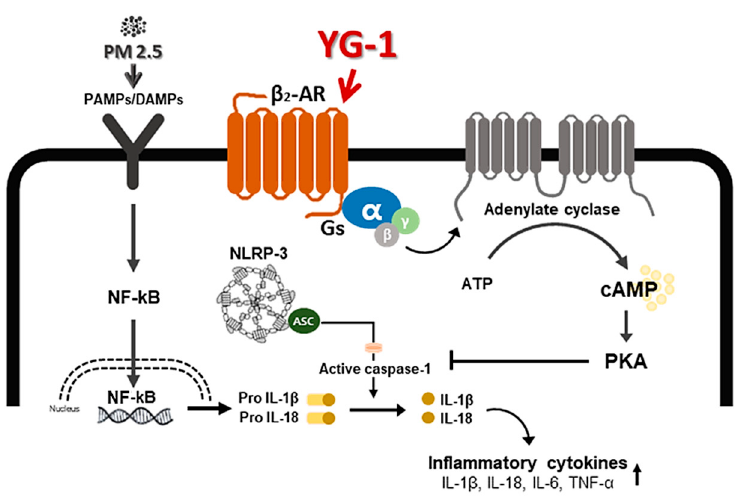
Figure 9. A schematic diagram of the effect of YG-1 extract on airway remodeling in fine particulate matter (PM2.5)-stimulated mice. YG-1 extract improved bronchial and lung inflammation by inhibit- ing NLRP3/caspase-1 signaling through β 2- adrenergic receptor stimulation in PM2.5 stimulated mice. Cont, control; PM2.5, fine particulate matter; Gs, G protein; α , G protein alpha subunit; β , G protein beta subunit; γ , G protein gamma subunit; β 2 -AR, β 2 adrenergic receptor; ATP, adenosine triphosphate; cAMP, cyclic adenosine monophosphate; PKA, protein kinase A; NF- κ B, nuclear factor kappa-light-chain-enhancer of activated B cells; Gs, G-protein subtype; NLRP-3, NOD-like receptor pyrin domain-containning protein 3; IL-. 1 β , Interleukin 1 beta; IL-18, Interleukin 18; TNF- α , tumor necrosis factor